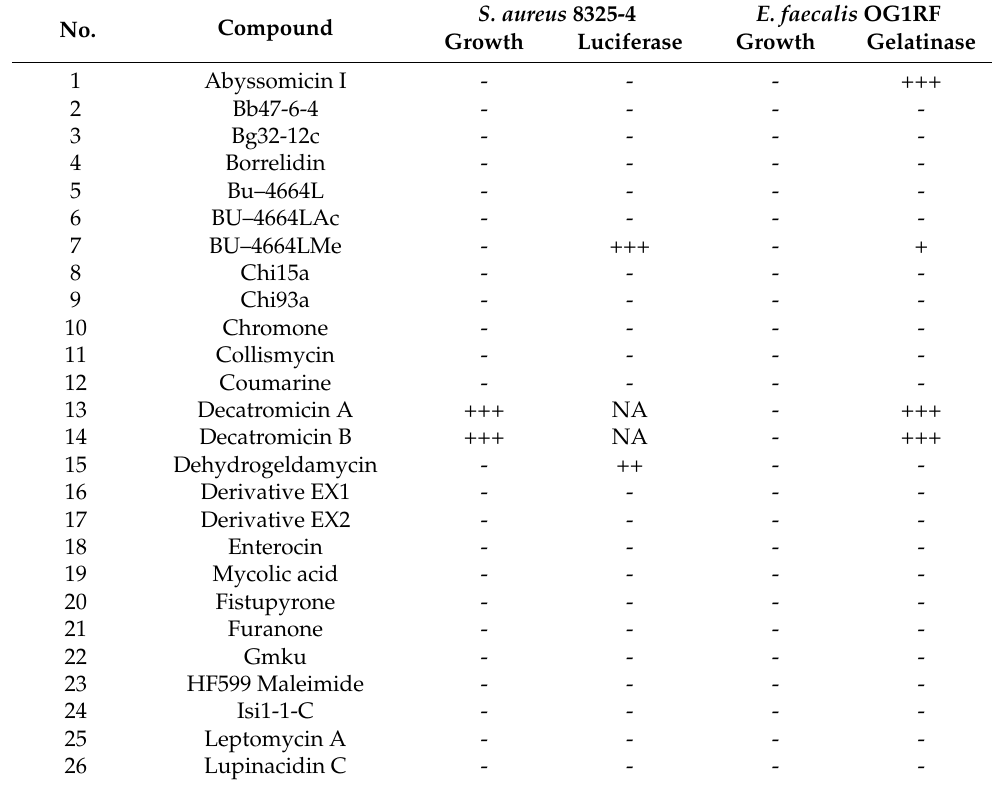
Table 1. Compound library screening against luciferase activity and gelatinase